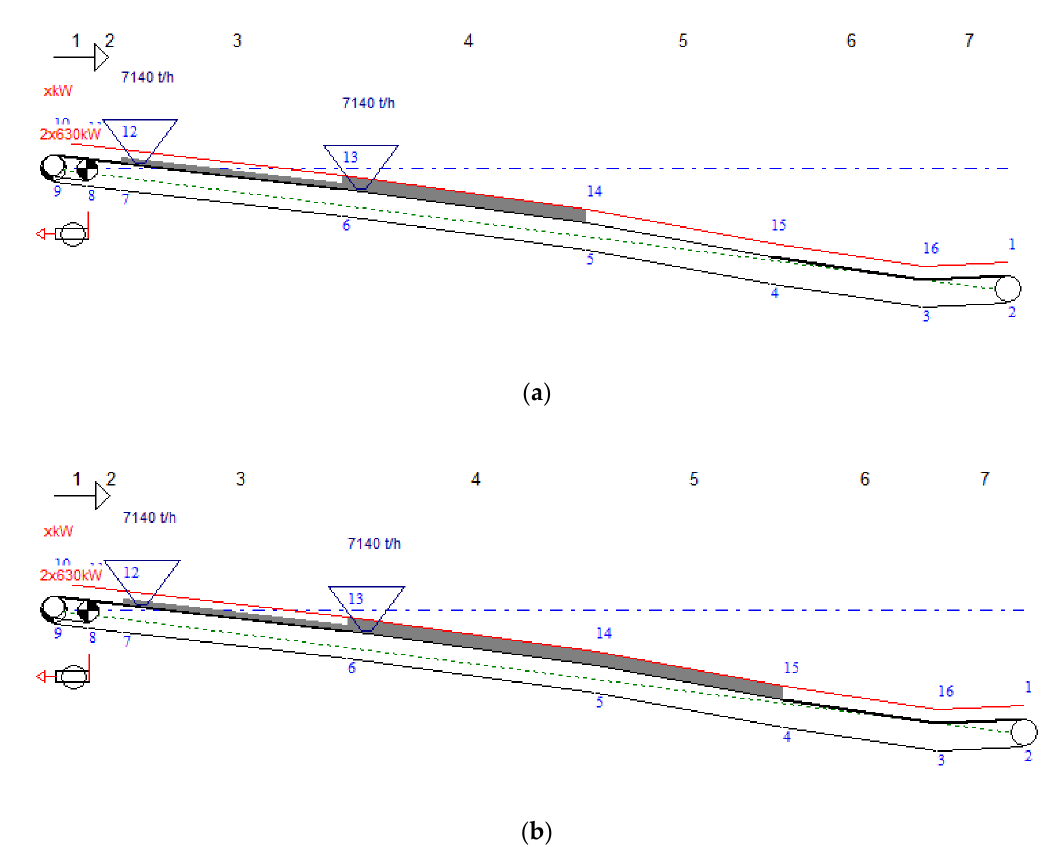
Figure 6. The profile of the study route of the overburden conveyor, loaded on two subsequent mining levels and being alternatively discharged on its route: ( a ) 1 mining level below the second loading point, ( b ) 2 mining levels below the second loading point (source: QNK-TT). Table 2. Variants of loading the analyzed conveyor on a ramp with an overburden stream from two excavators, A and B, at subsequent mining levels (the conveyor is discharged on its route) and the resulting drive